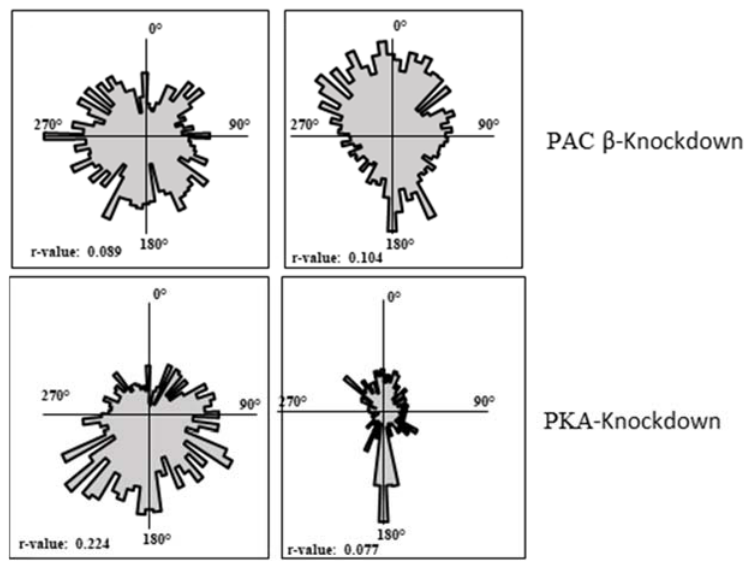
Figure 4. Representative circular histograms showing the directional movement of wild ‐ type, PAC α‐ , PAC β‐ , and PKA ‐ silenced cells after 4 days of electroporation. Gravitaxis was impaired in PAC α‐ and PAC β‐ silenced cells.